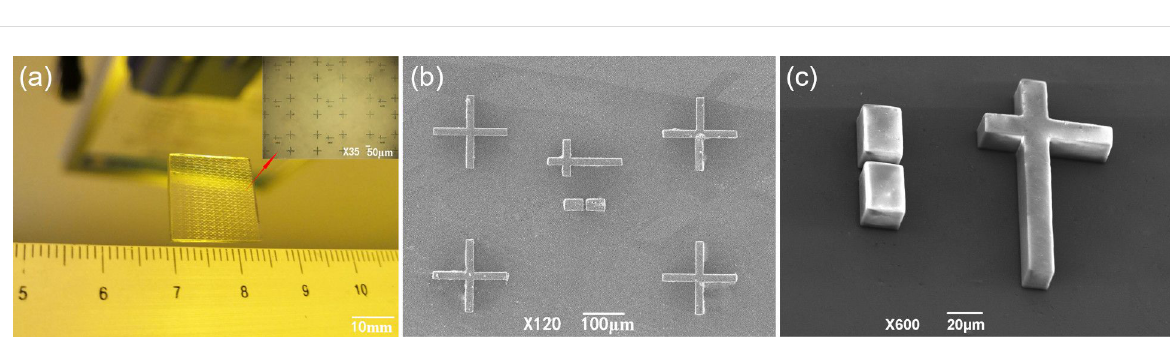
weight fraction of the SiO 2 nanoparticles is calculated accord- ing to Equation 1 [20]: